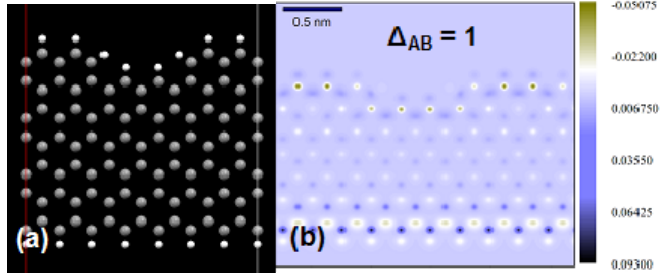
Figure 5. ( a ) Structure of mono-hydrogen-terminated interpore graphene nanoribbon (GNR) region, which introduces small curvature (defects) with Δ between the number of removed A and B sites of the graphene sublattices at zigzag edges) on the upper edge, used for first-principles calculations based on Lieb’s theorem. The dark and white atoms are carbon and hydrogen, respectively; ( b ) Calculated spin-density distribution of quasi-GNR for ( a ), which gives the edge magnetic moment of 0.2 μ lower